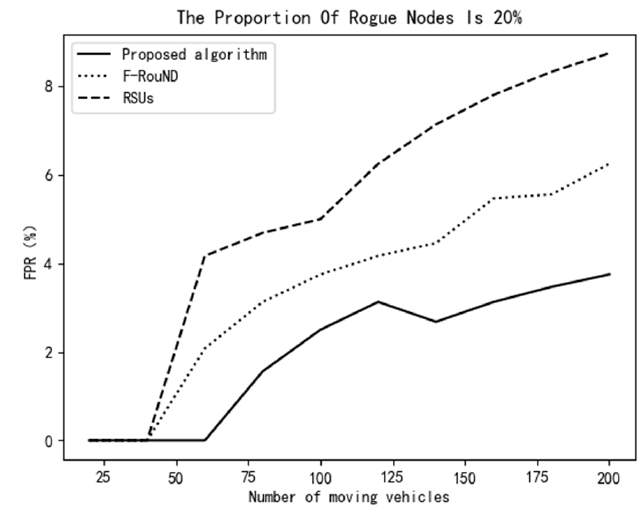
Figure 10. Variation of FPR vs. the number of mobile vehicles (20%).